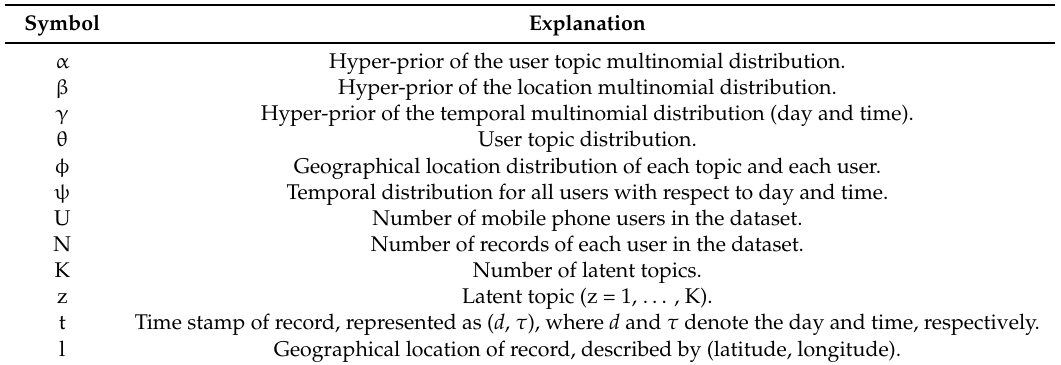
Table 6. Explanation of symbols used in Figure 2.